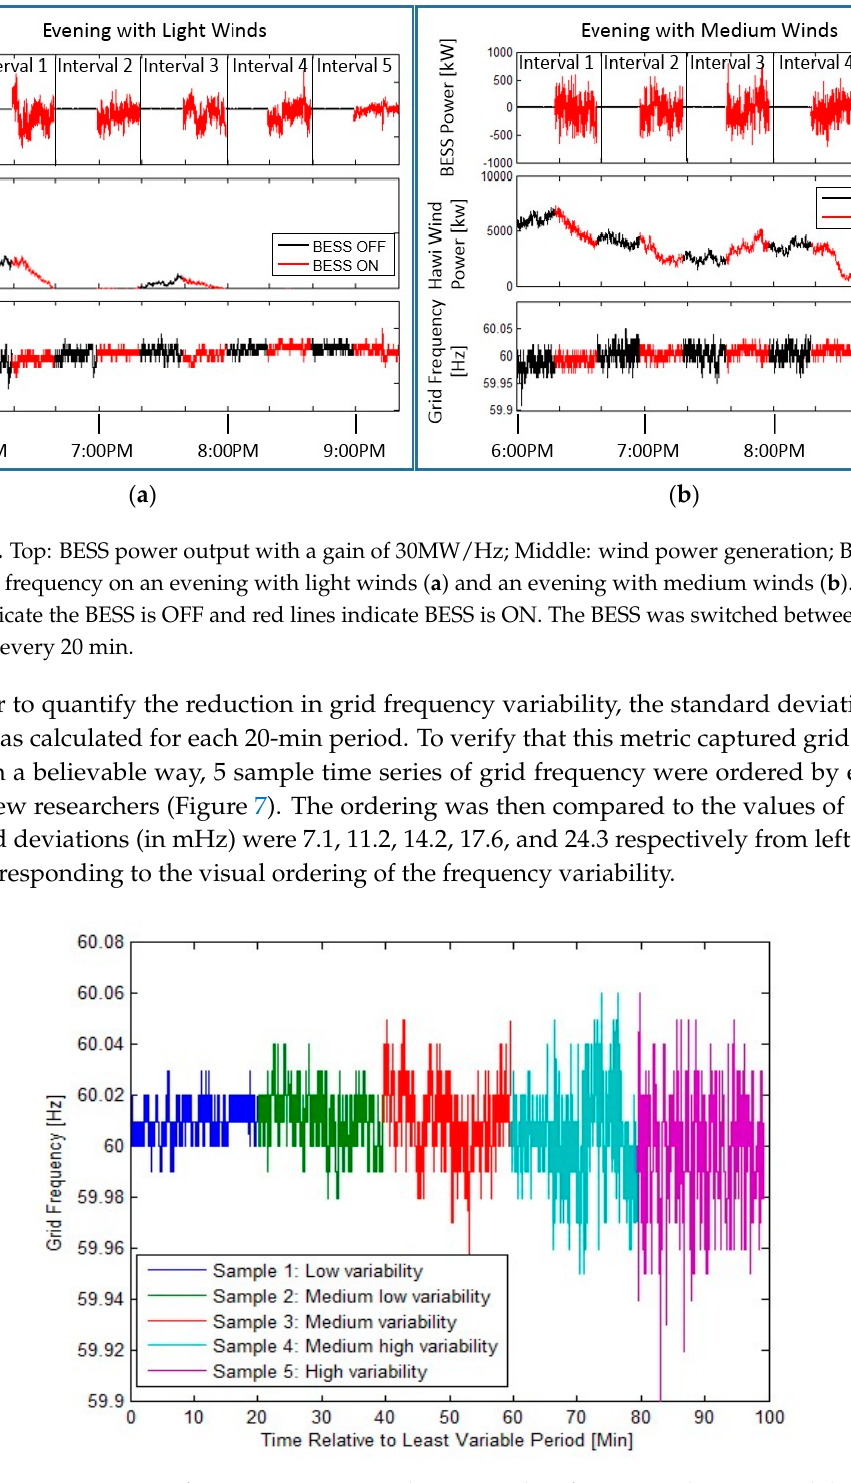
Figure 7. Five 20-min frequency time series shown in order of increasing by-eye variability.